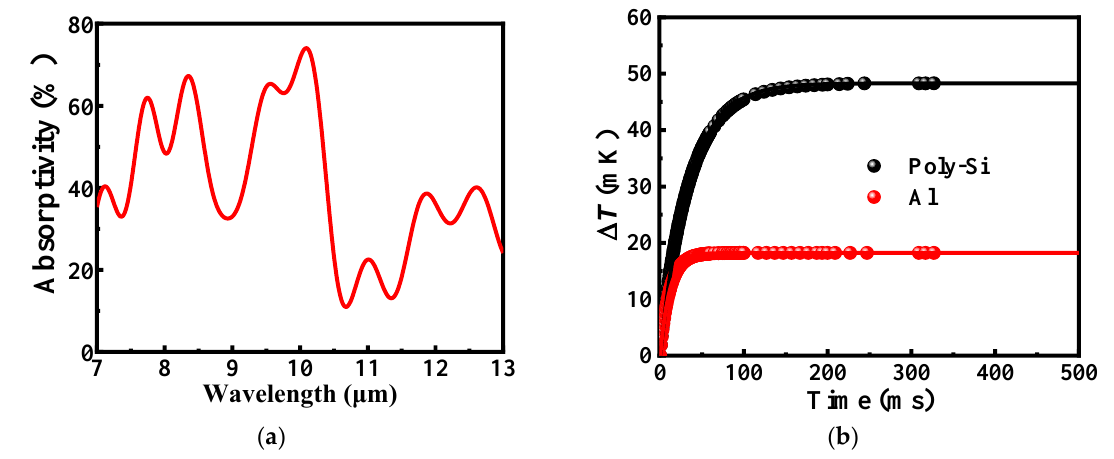
Figure 2. ( a ) the simulated absorption spectra in the range of 7 – 13 μm of both microbolometers by FDTD software, ( b ) the simulated temperature rises of microbolometer as a function of time by Ansys workbench software. The curves represent the fitting result of simulated data by Equation (1).